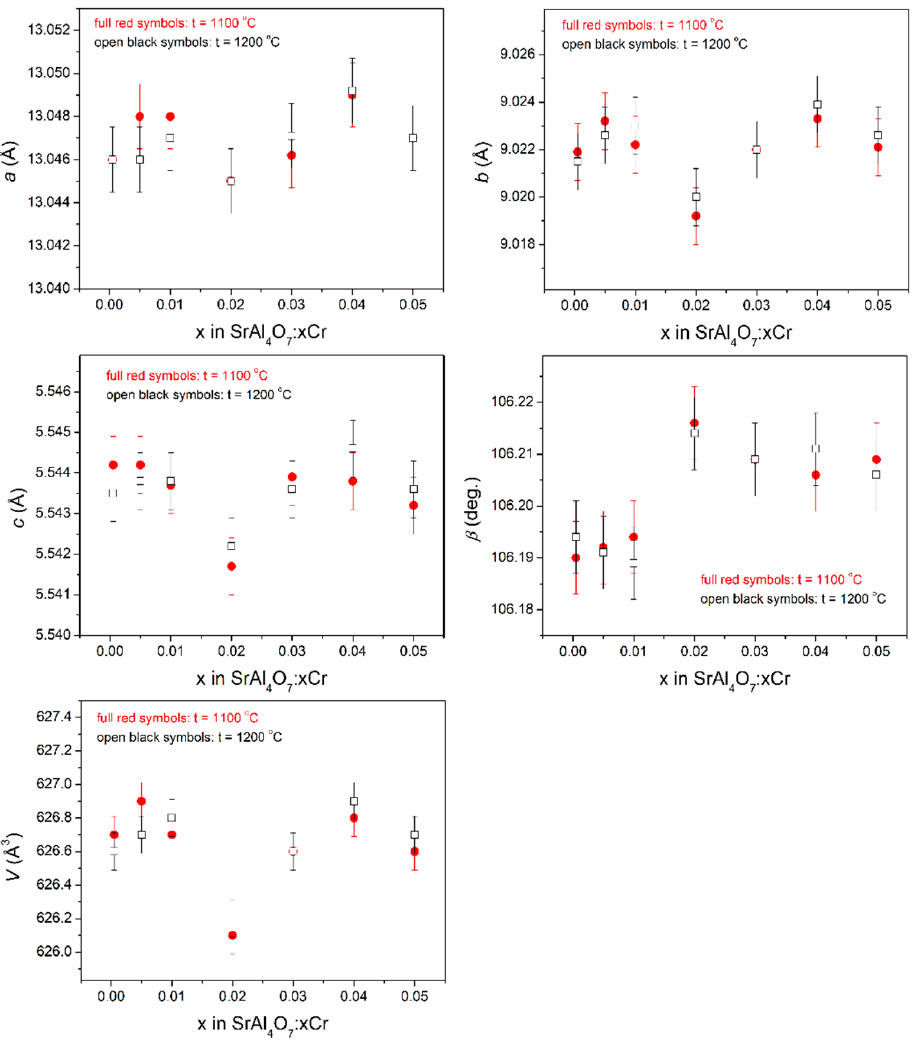
Figure 7. Dependencies of the lattice parameters and volume of the SrAl 4 O 7 :xCr 3+ unit cell on nominal content of chromium in